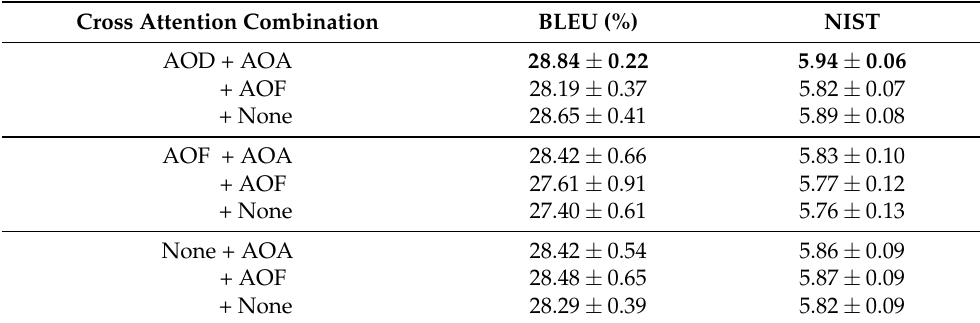
Table 7. Cross attention ablation. The combination is in the format of intermediate to leaf + leaf to intermediate such as AOD + AOA. None symbol means no attention. For leaf nodes, AOF means at- tending all intermediate nodes. Similarly, AOF means attending all leaf nodes for intermediate nodes. Bold means the best